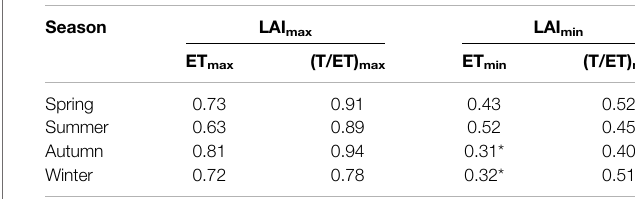
TABLE 2 | Correlation coef fi cients of LAI max (LAI min ) with ET max (ET min ) and (T/ ET) max [(T/ET) min ] from SEN during the period 1982 – 2015 (* indicates not passing signi fi cance test at 0.05